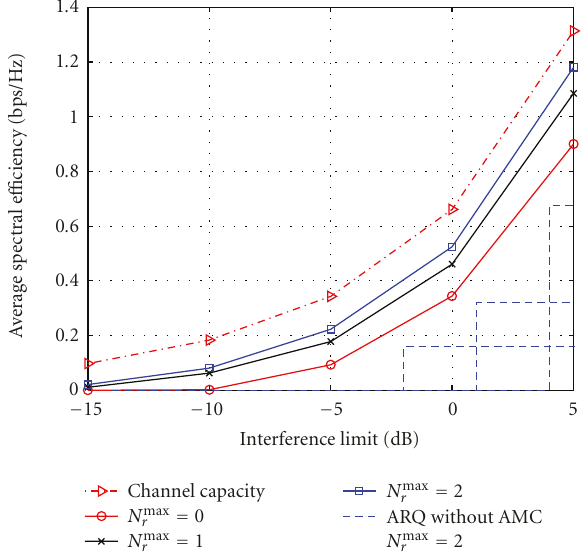
Figure 5: Average spectral e ffi ciency versus interference limit for Nakagami distributed ( m = 2) channel